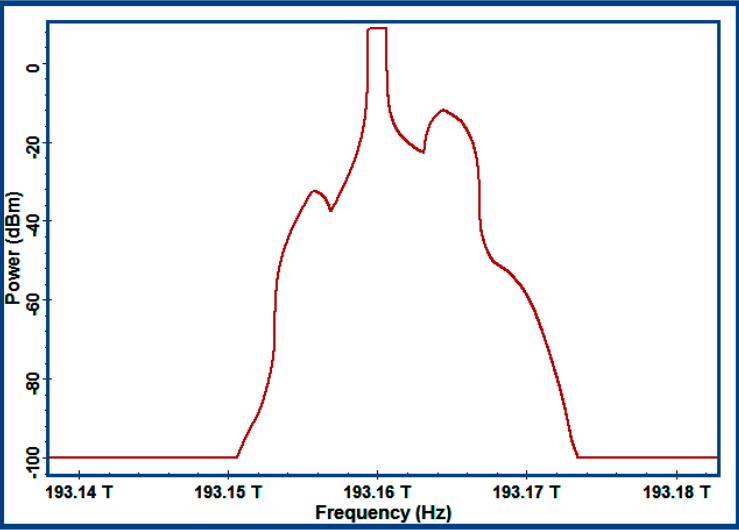
Figure 8. The optical spectrum of the single-sideband optical signal.